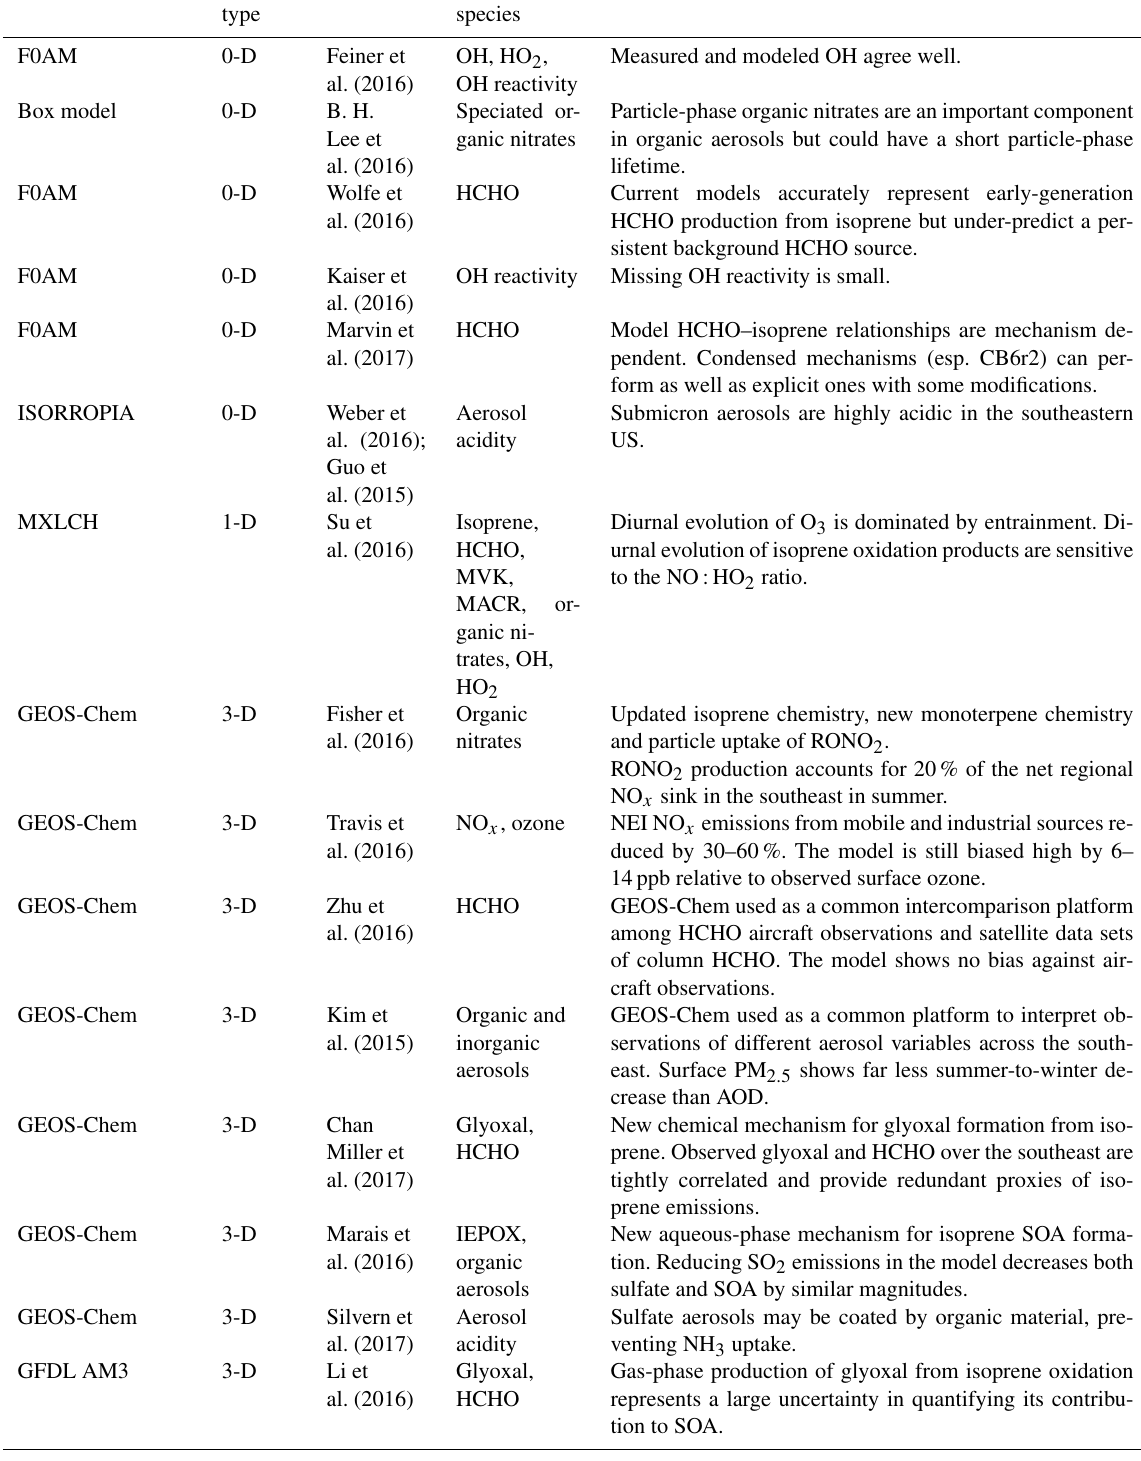
Table 1. A subset of model evaluations for SAS observations (till